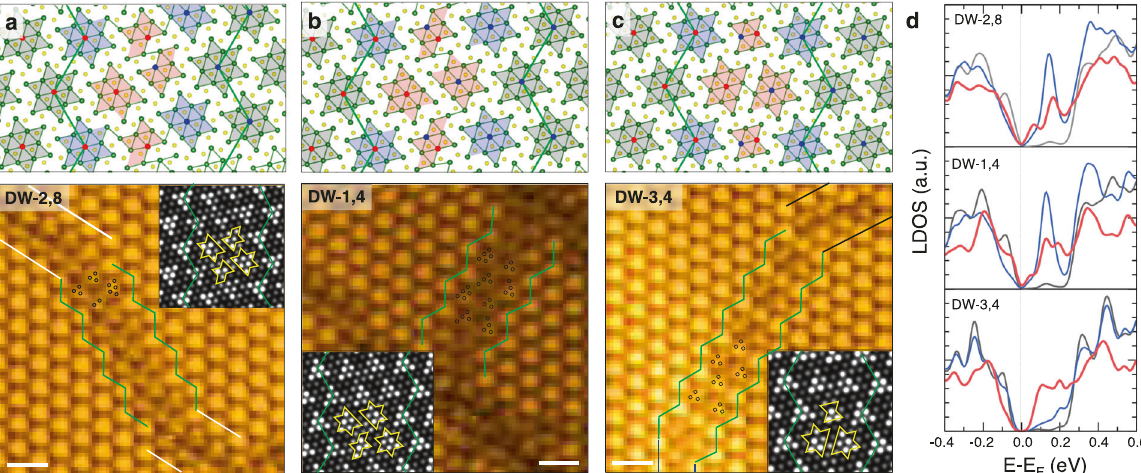
Fig. 4 Atomic and electronic structure of zigzag domain walls. a DW-2,8, b DW-1,4, and c DW-3,4. Red and blue dots in atomic structures denote the center site of the David-star cluster of left and right domains, respectively. The bottom panels are experimental STM images (scale bar = 2 nm). Insets are simulated STM images as same as Fig. 3. Green zigzag lines denote the domain edge. d Local DOS of DW-2,8, DW-1,4, and DW-3,4. Line colors in d correspond to the localized states at the clusters with the same color in atomic